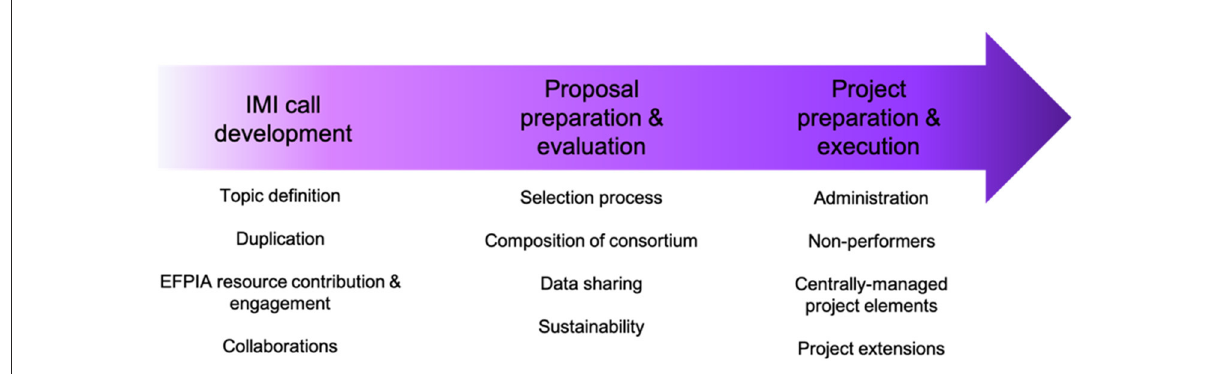
FIGURE4 Challenges and opportunities for improvement across the IMI project